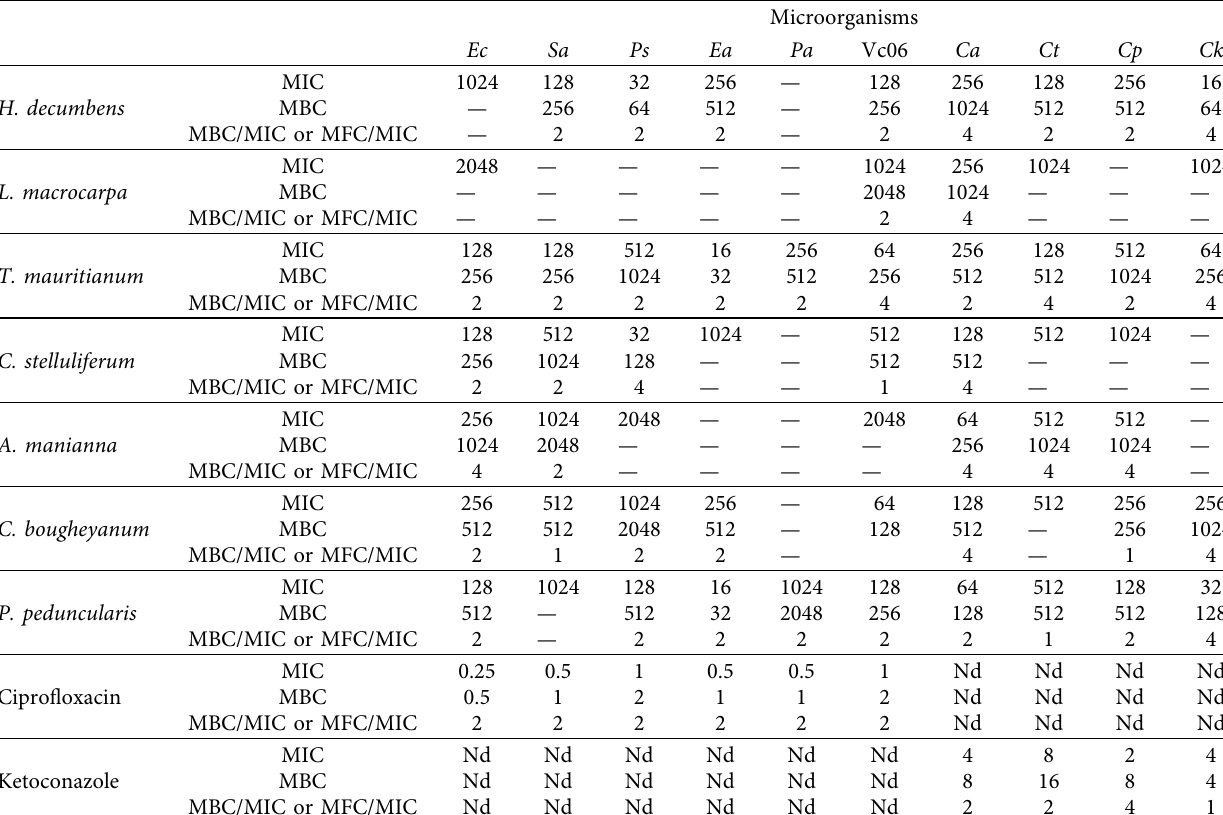
Table 4: Minimum inhibitory concentration (MIC in µ g/mL), minimum bactericidal or fungicidal concentration (MBC or MFC in µ g/mL), and MBC or MFC/MIC ratio of the seven selected medicinal plants.